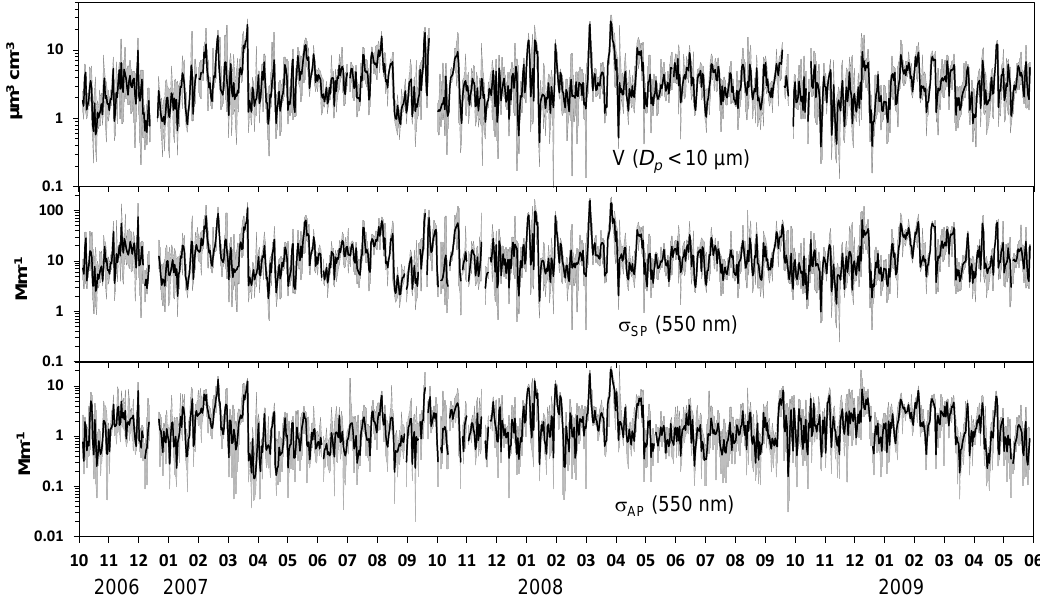
Fig. 2. Particle volume concentration, scattering coefficient ( σ SP ) , and absorption coefficient ( σ AP ) at λ = 550nm measured at SMEAR II in 13 October 2006–31 May 2009. Black line: daily median; the gray shaded area: the 95 percent range (2.5th and 97.5thpercentiles) of the hourly-averaged data in each day. Table 1. Statistical summary of aerosol optics data measured at Hyyti¨al¨a SMEAR II station in 13 October 2006–31 may 2009. N/N tot